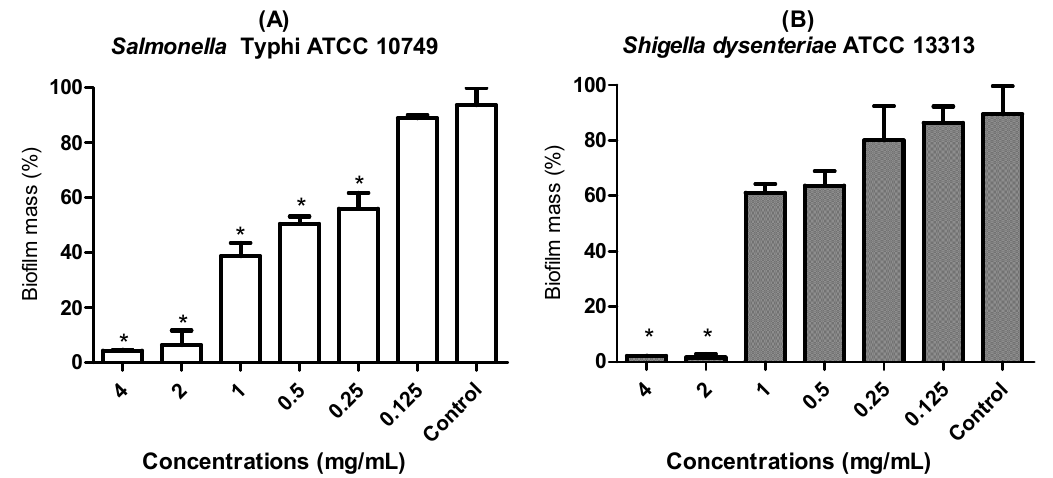
Figure 3. Inhibition of Salmonella typhi ( A ) and Shigella dysenteriae ( B ) biofilm formation by LaEO I. Values are expressed as mean ± SEM of three assays, each in triplicate. Control: culture medium + microorganism. The analysis was performed by ANOVA, with Dunnett’s post-test and p value < 0.05 (*) when compared to the control.